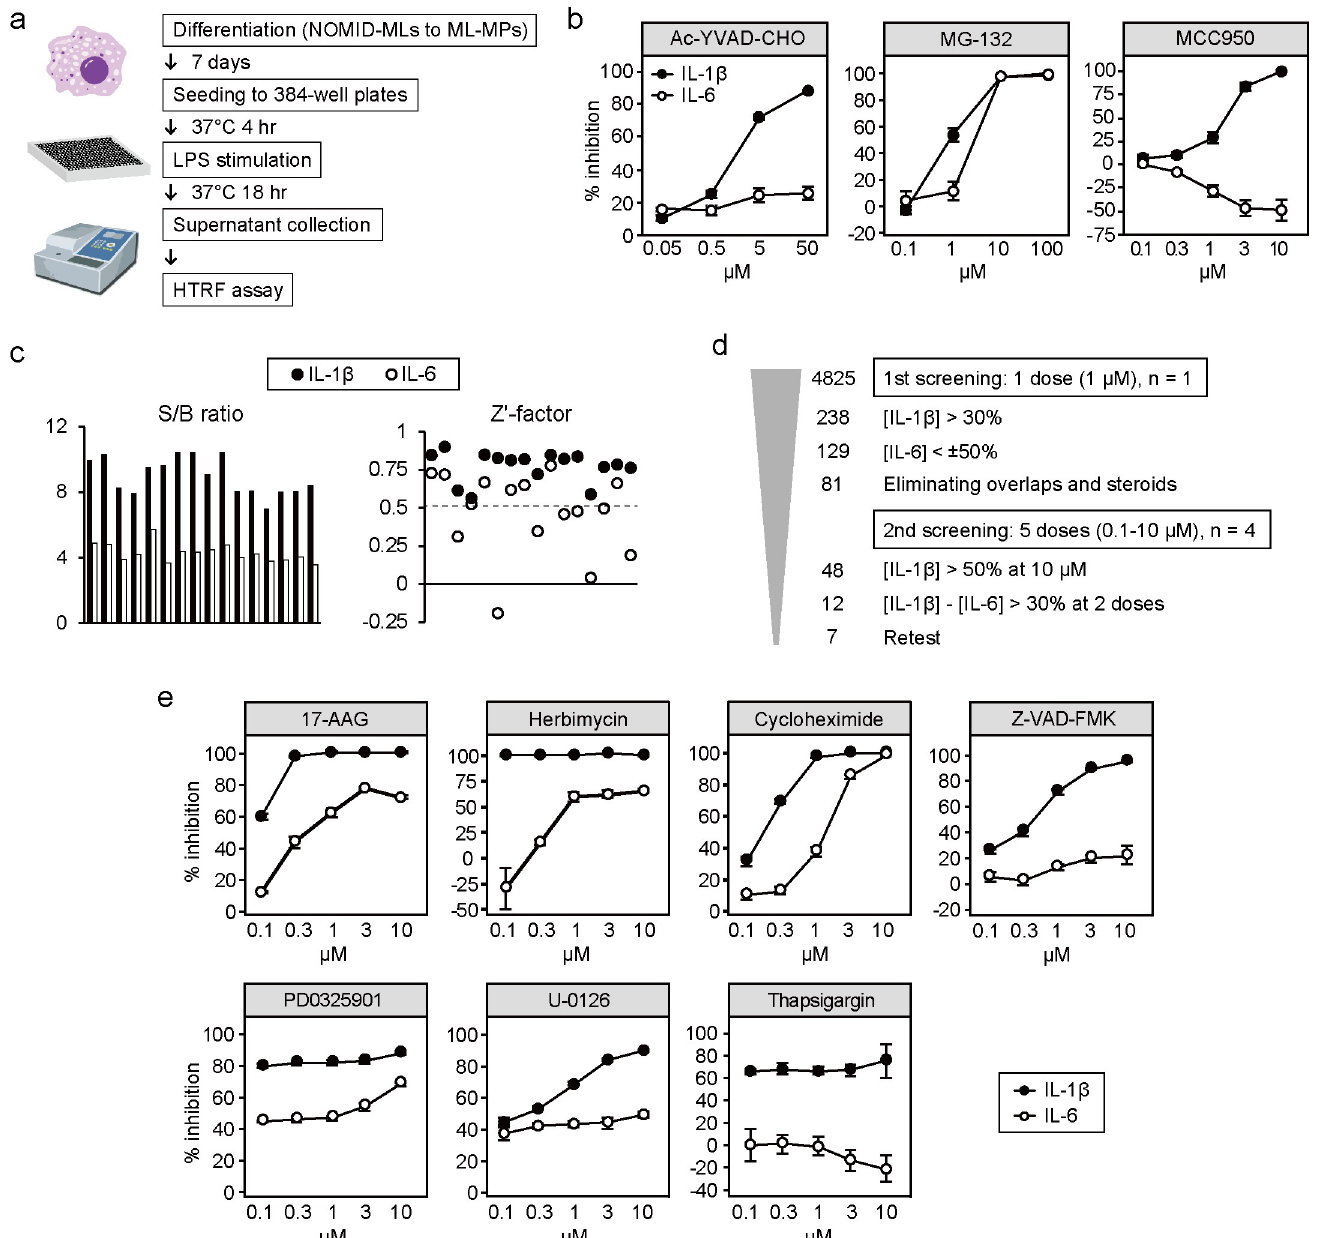
Fig 3. Establishment of an HTS platform using ML-MPs. (a) Schematic illustration of the compound screening. (b) Dose-dependent inhibition of IL-1 β (closed circles) and IL-6 (open circles) secretion by Ac-YVAD-CHO, MG-132 and MCC950. Bars show the mean ± S.E.M. of five experiments. (c) The quality of the assay system was evaluated. Signal-to-background ratios and Z’-factors of 16 plates for IL-1 β (closed) and IL-6 (open) are shown. (d) Criteria and number of hit compounds. [IL-1 β ] and [IL-6] indicate the percent inhibition of IL-1 β and IL-6 secretion, respectively. (e) Dose-response curves of the hit compounds. Bars show the mean ± SD of four